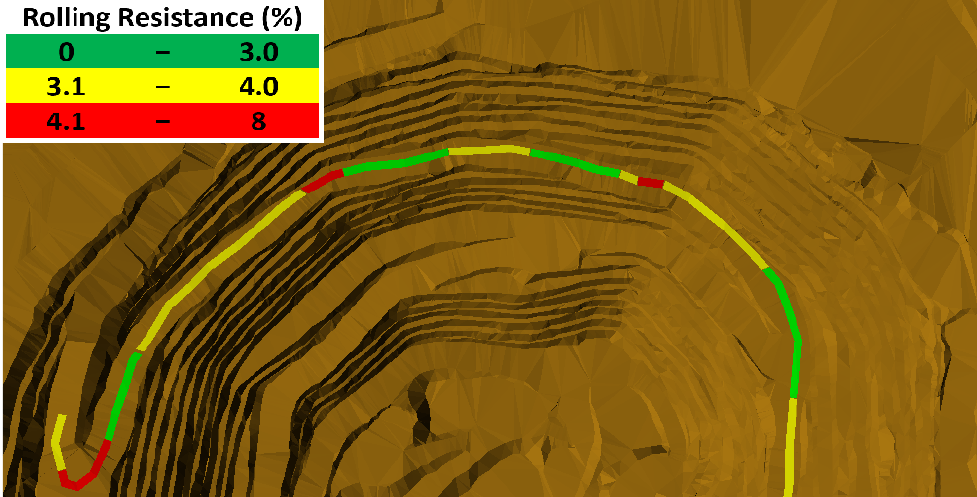
Figure 1. Conceptual representation of the differentiated deterioration between road segments in an open pit mine.